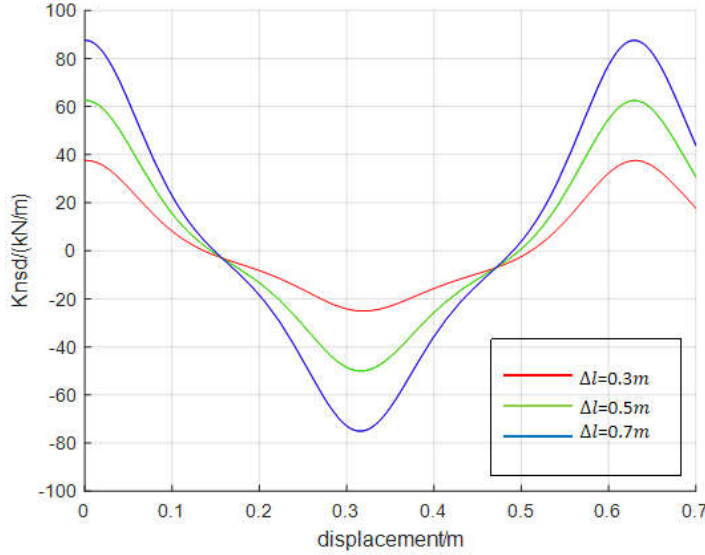
Figure 11. Influence of preload of Belleville spring on negative stiffness.